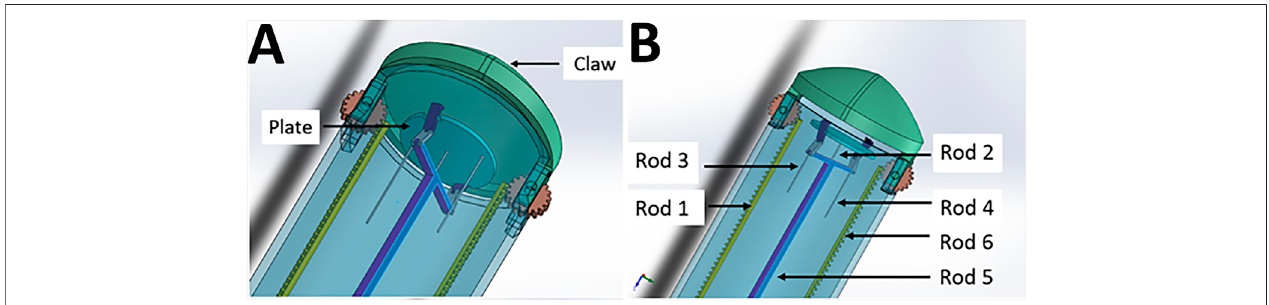
FIGURE 1| The Claw design in detail. (A) The plate (transplantation platform)where the hydrogel patch sits, enclosed by the “ claw ” tocreate a safe compartment. (B) Controller rods allow opening of the claw (Rod 1 and 6), changing the phasing angle of the plate (Rod 3 and 4), release of the patch securing clips (Rod 5) and protrusionandretractionoftheplatform(Rod5supportedbyRod2).Forclarity,Rods3and4areshowncutshortbutwouldactuallytravelthroughtheinstrumenttothe proximal (control unit) end with the other rods (see also Figure 6C which shows the whole length and proximal connections of rods to micro-servo motors).